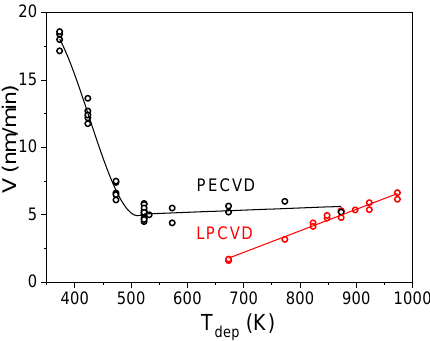
Figure 1. Dependence of the film growth rate on the deposition temperature in LPCVD and PECVD processes.